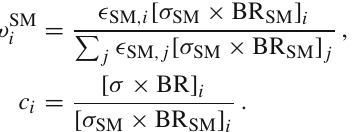
Simplified Template Cross Section (STXS)